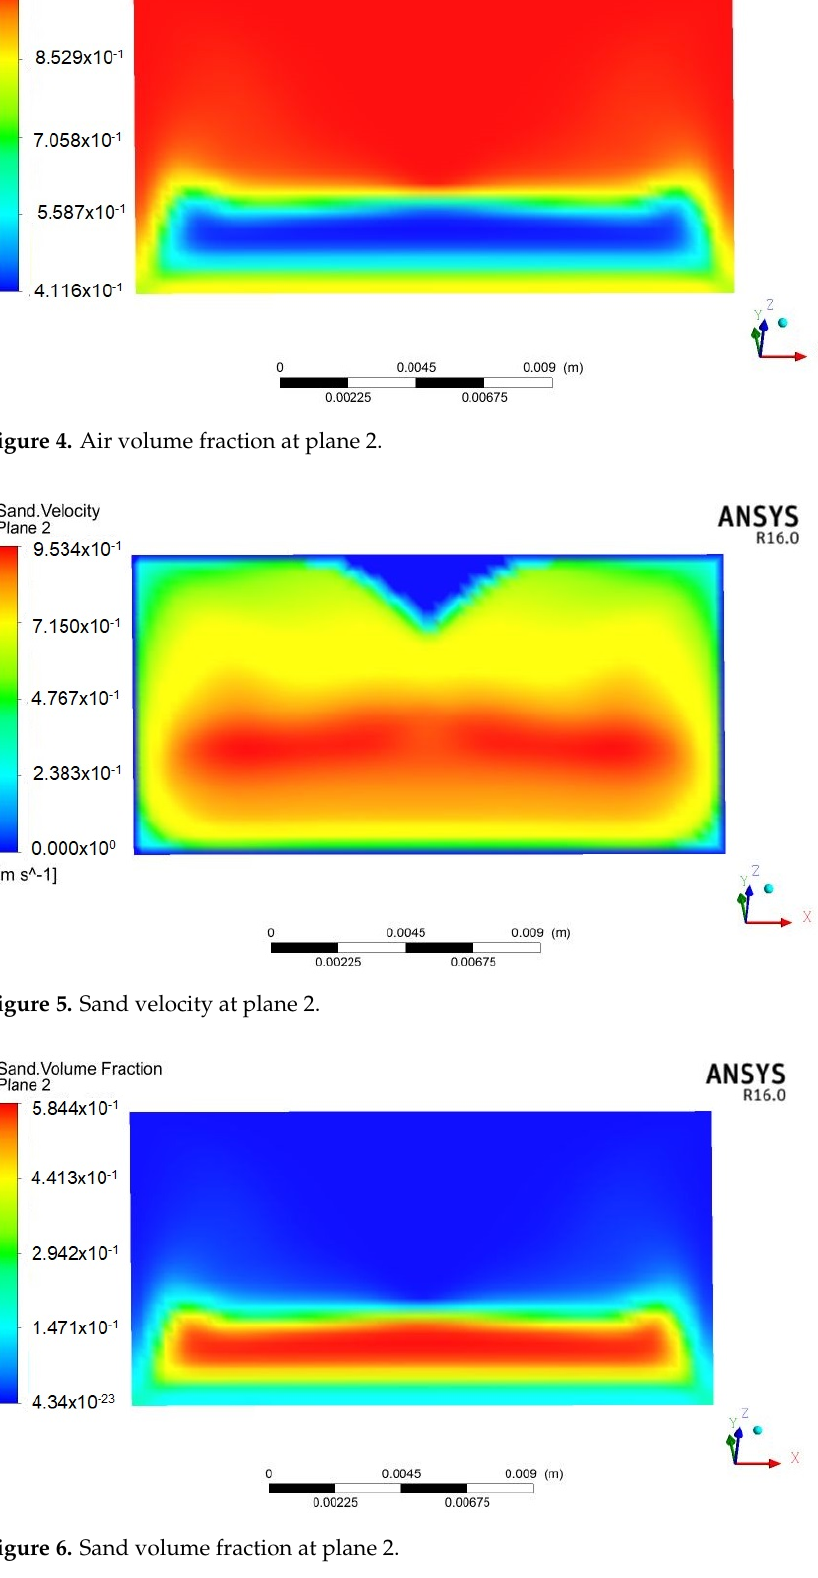
Figure 7. Air velocity at the outlet. Figure 8. Air volume fraction at the outlet.